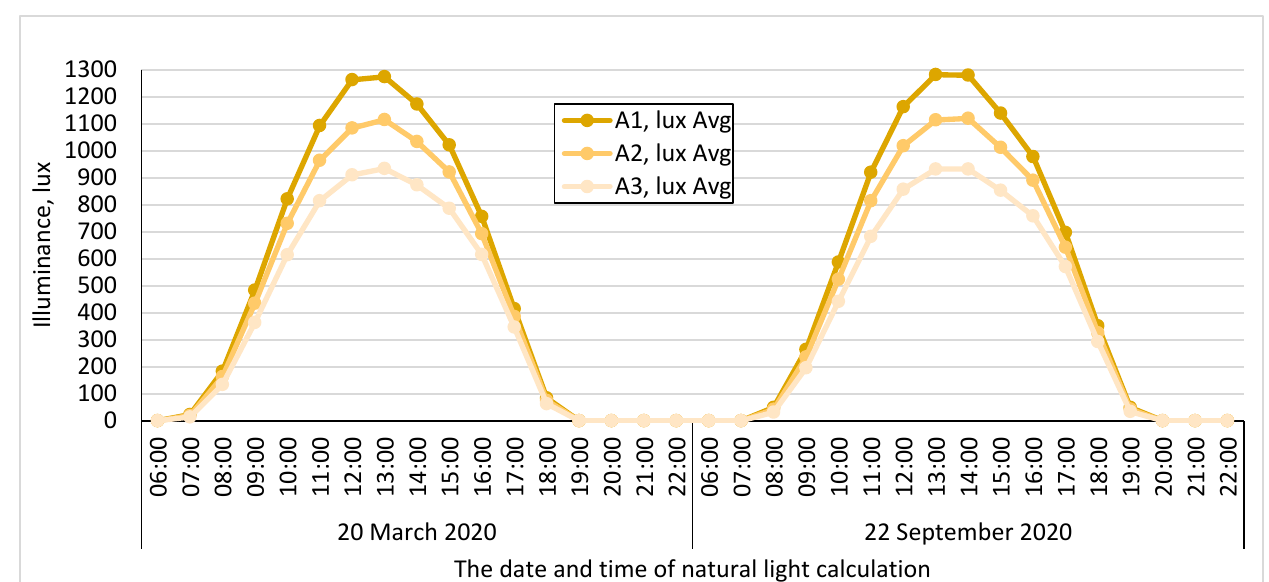
Figure 7. The comparison the average illuminance values.